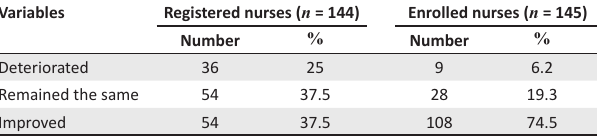
TABLE 5: In the past year would you say the quality of care in your hospital has …? Variables